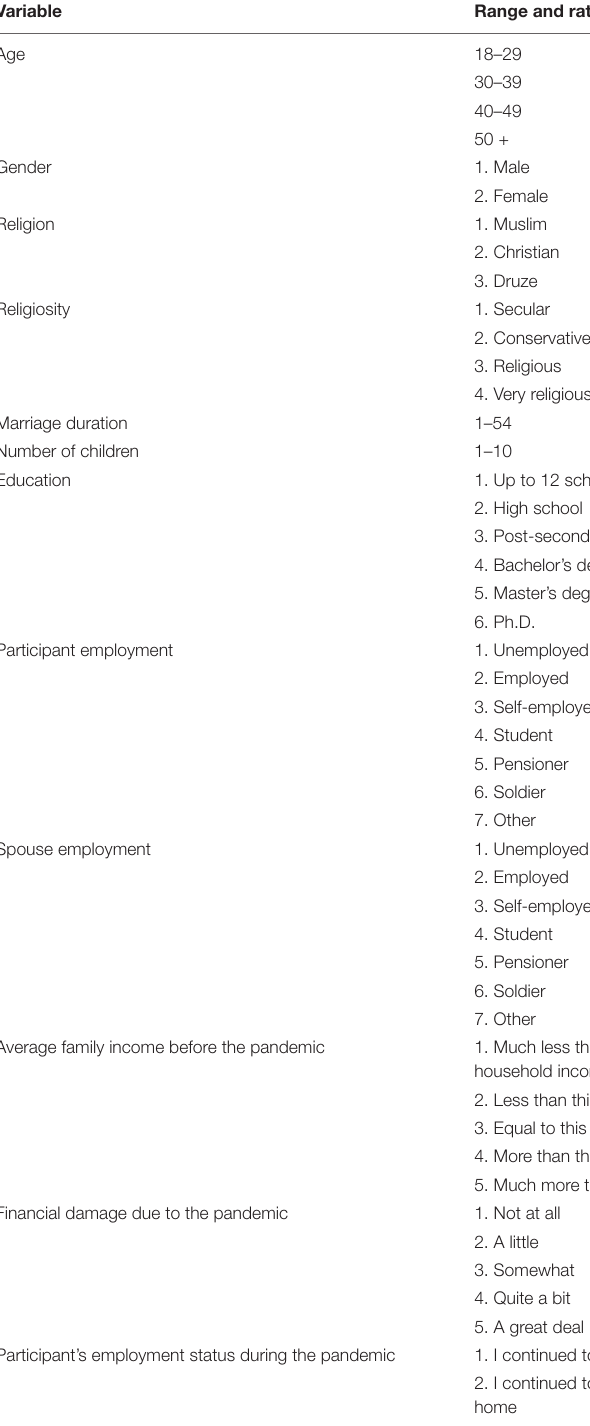
TABLE 1 | Sample sociodemographic characteristics: descriptive statistics ( N = 480).